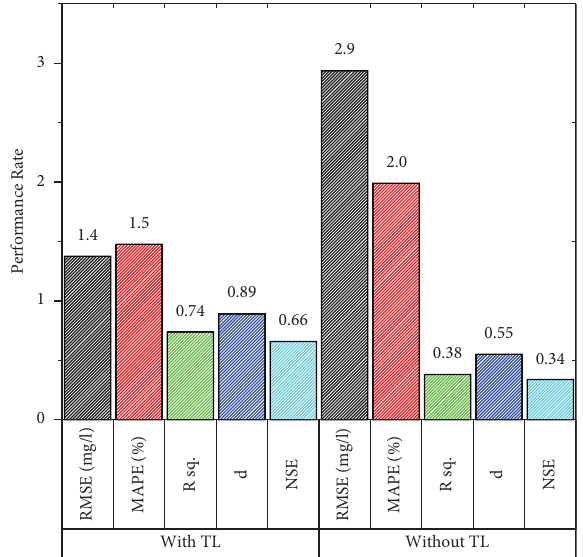
Figure 1: Comparative performance of the various models with and without considering the transfer leaning